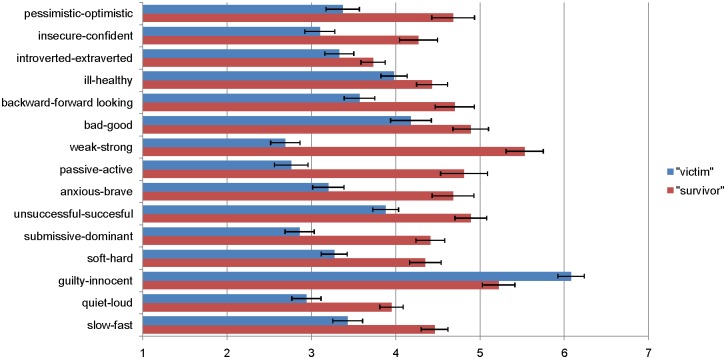
Means of semantic differential ratings by label condition (Study 1, English-language sample, n = 86).Error bars represent standard errors.